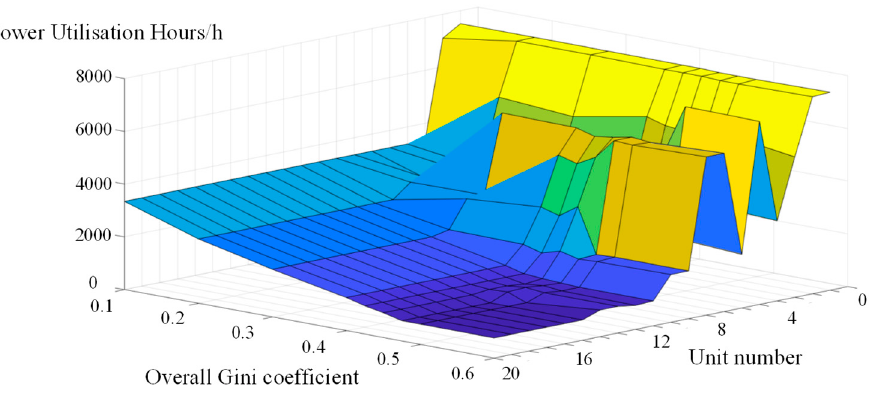
Figure 6. Annual electric generation hour curve of each unit under different overall Gini coefficient values.